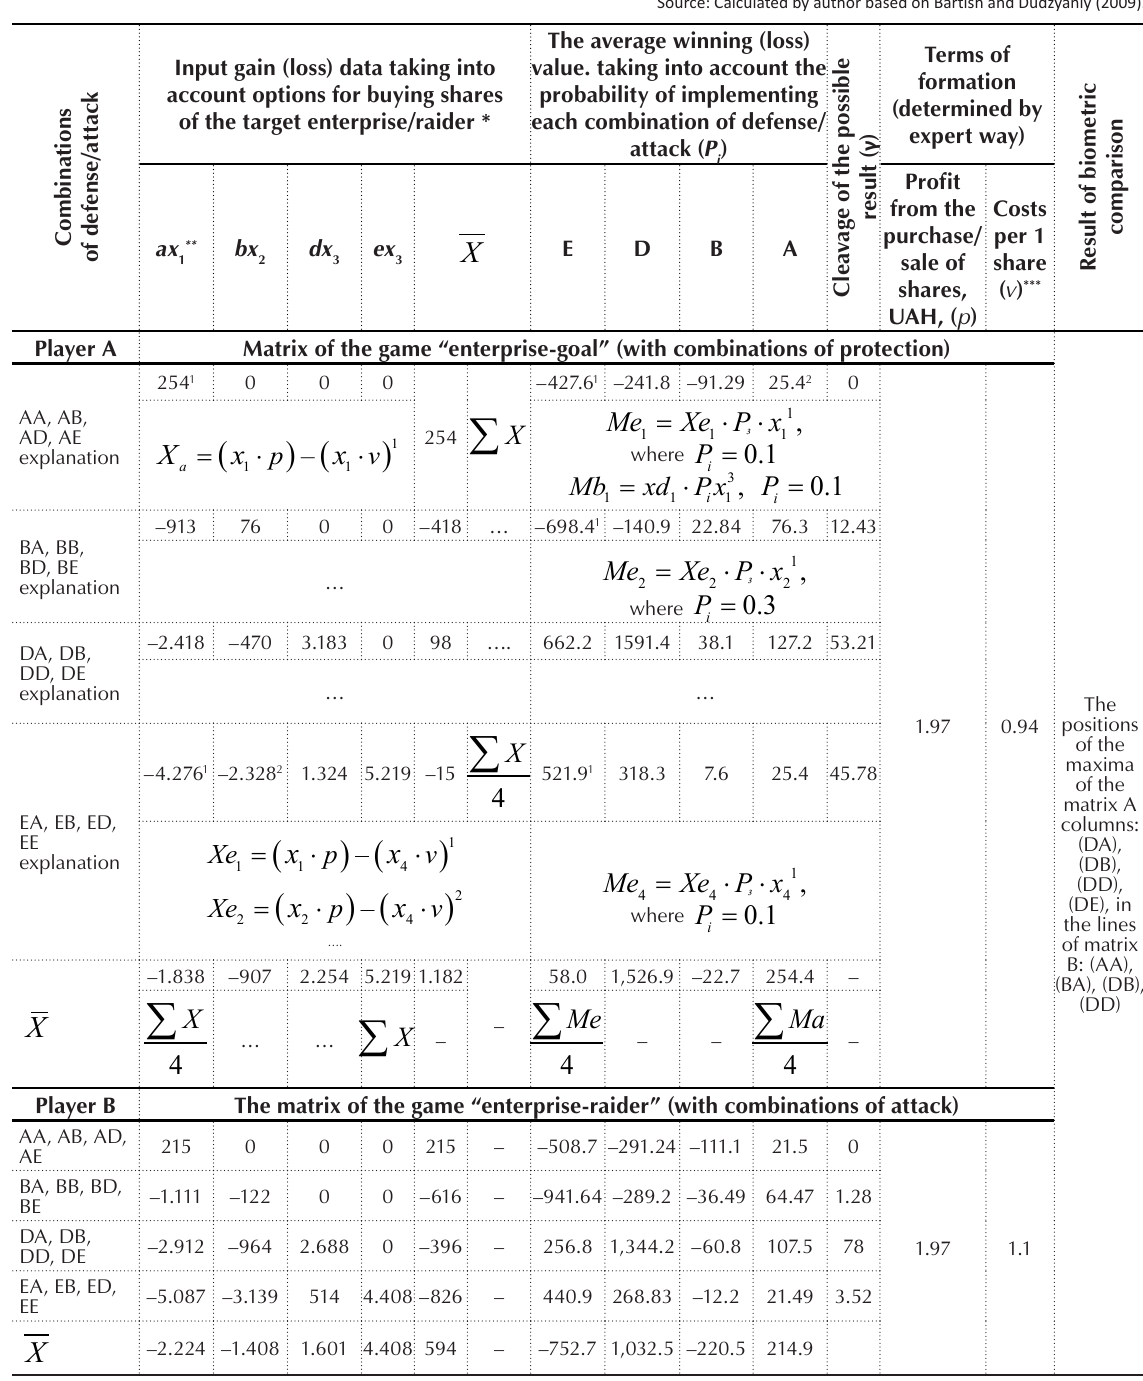
Table 1. Payment matrix of LLC “TENT TRANS” – PJSC “Transcarpathia Auto”, based on the